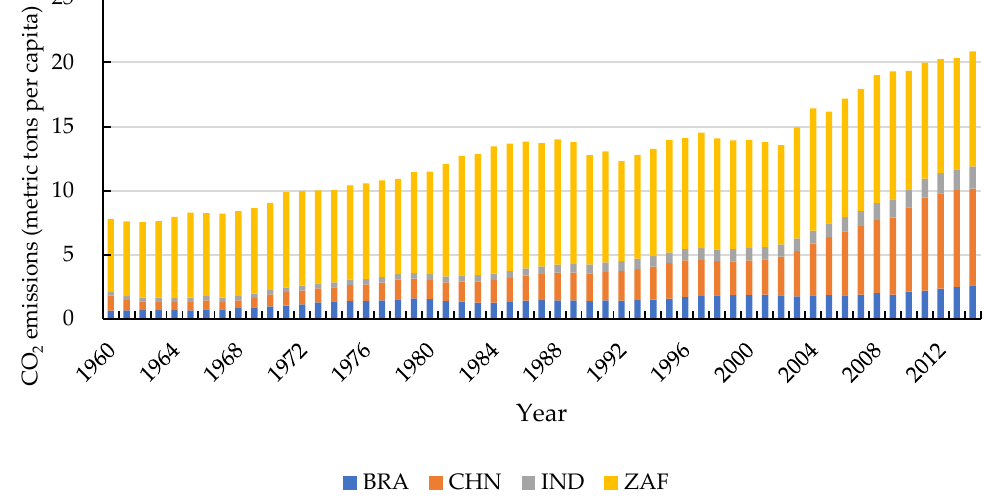
Figure 2. Per capita CO 2 trends of the BRICS countries from 1960 to 2014. (Source: World Bank. BRA stands for Brazil, CHN stands for China, IND stands for India, ZAF stands for South Africa.) Table 1. CO 2 emissions of the BRICS countries in 2014.